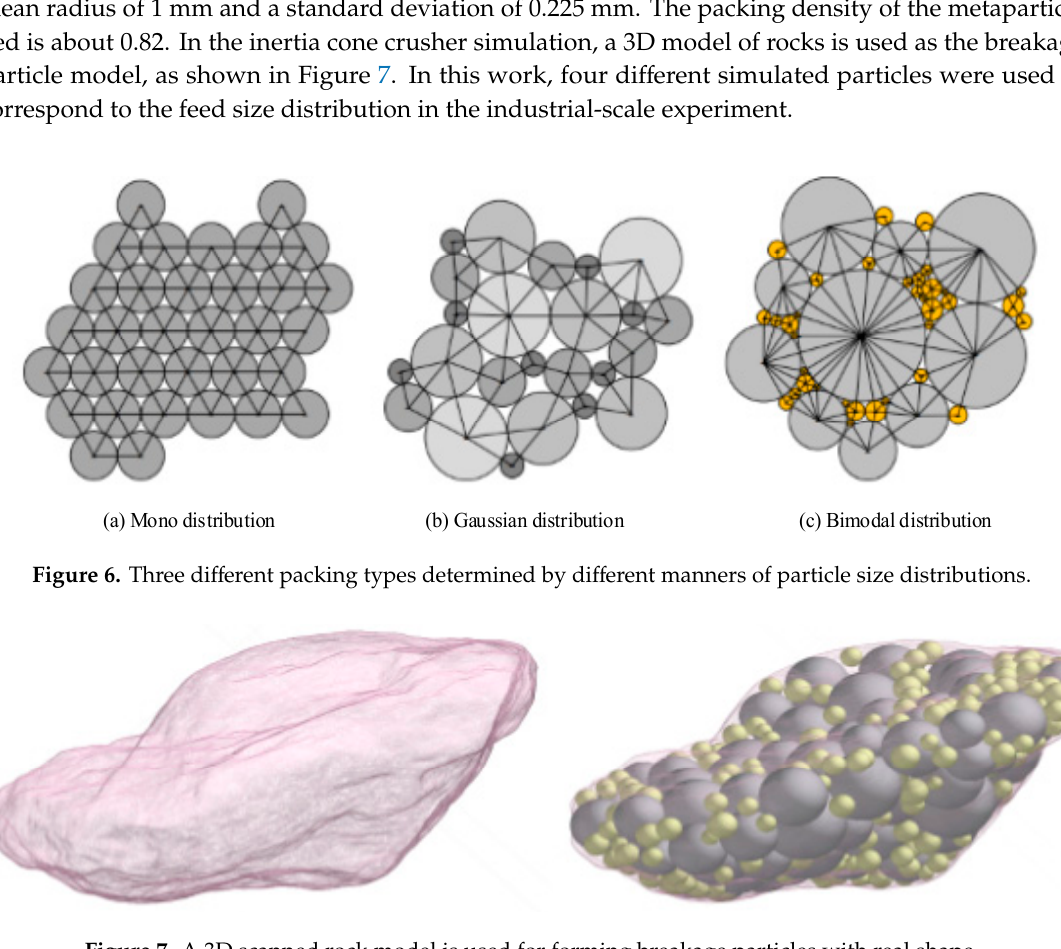
Figure 7. A 3D scanned rock model is used for forming breakage particles with real shape. Figure 8. Photo of the crushing test on a white marble particle from the feed sample.